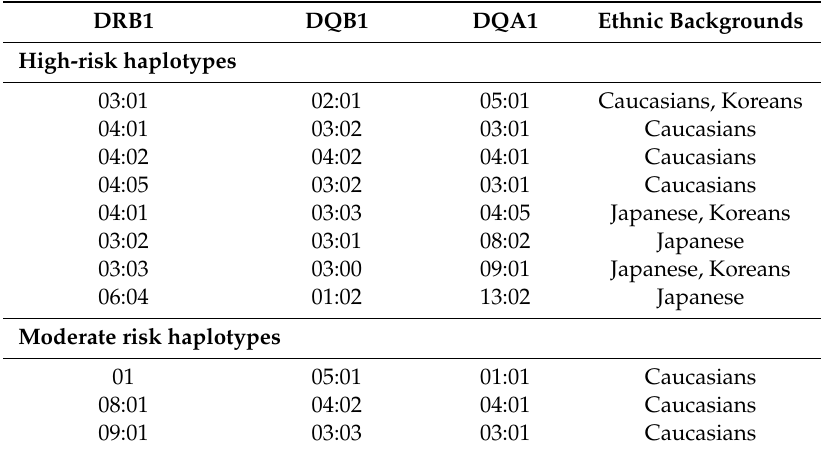
Table 1. Diabetes risk by human leukocyte antigen (HLA) haplotypes [2,7–9].